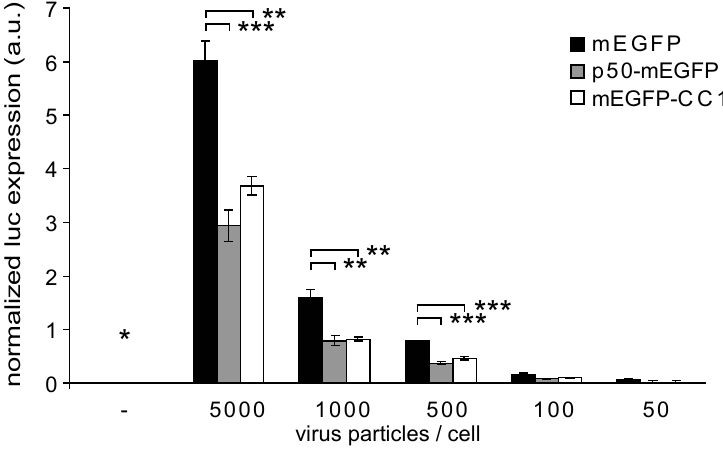
Figure 5. Dynactin interference inhibits HAdV5 transduction. HeLa cells were transiently transfected with mEGFP, p50-mEGFP or mEGFP-CC1 for 16 h, incubated in Hoechst containing medium and infected with the indicated virus particle to cell ratios for 9 h. Cells were imaged with an ImageXpress Micro Imaging Station (Molecular Devices) in the Hoechst and mEGFP channel 30 min before lysis and luciferase expression was detected, normalized to the average mEGFP expression and to number of nuclei detected in 16 sites imaged per well. The mean values ± SEM of three independent experiments are shown. * indicates samples with luciferase expression below the detection limit, ** p < 0.02, *** p <